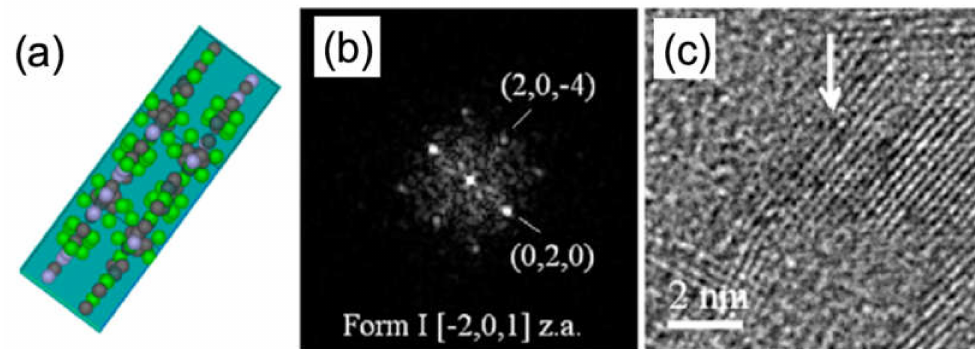
Figure 8. Ca ff eine-glutaric acid (CAF-GLA) co-crystal of polytype I [5]. The kind of polytype of Figure 8. Caffeine-glutaric acid ( CAF-GLA) co-crystal of polytype I [5]. The kind of polytype of the thenanoparticleisunivocallydeterminedbycomparingthestructureoftypeI,viewedalongthe[ − 2,0,1] nanoparticle is univocally determined by comparing the structure of type I, viewed along the [−2, 0, zone axis in ( a ), with the experimental di ff ractogram ( b ) and the HRTEM image ( c ). The arrow points 1] zone axis in ( a ), with the experimental diffractogram ( b ) and the HRTEM image ( c ). The arrow the region from which the di ff ractogram was extracted (reprinted by courtesy from Hasa et al. [5]). points the region from which the diffractogram was extracted (reprinted by courtesy from Hasa et al. [5]).